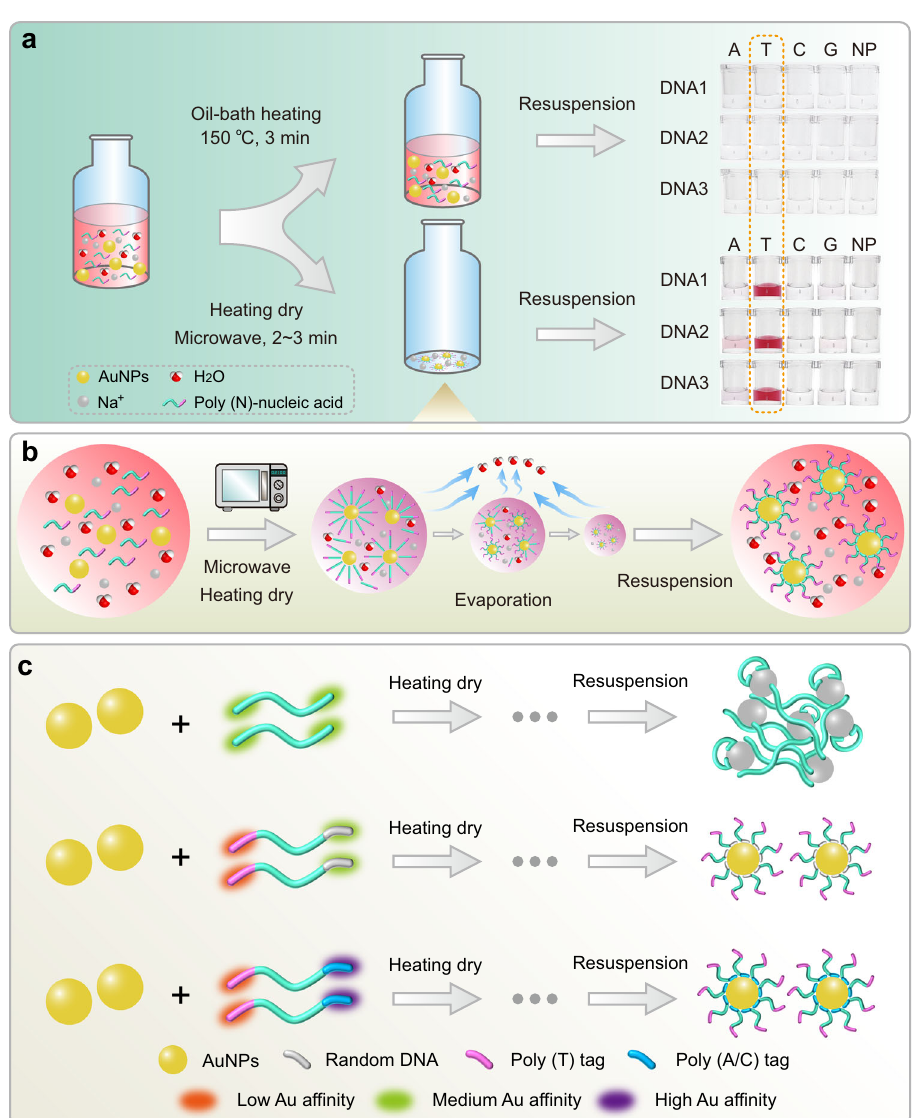
Fig. 5 Mechanism description on DNA-AuNP conjugation by the MW-assisted heating-dry method. a Photographs showing a failed labeling with solely heating at 150 °C for 3 min, while there was a successful labeling of poly (T)-tagged DNA with heating-dry method. Poly (A/C/G)-tagged DNA and non- poly base (NP) DNA probes exhibited failed labeling. An inef fi cient and failed labeling will lead to the AuNPs aggregation. b MW-assisted heating-dry method involves two consecutive processes: (i) MW-assisted heating induced high temperature unwinds the coiled structure of oligonucleotides. (ii) MW- assisted water evaporation concentrates the DNA/RNA, AuNPs and salt, thereby accelerating the attachment of DNA/RNA on the AuNPs surface. c DNA sequences without poly (T) tag present medium Au af fi nity at both terminals. Under heating-dry conditions, DNA adsorbed on the AuNPs surface disorderly. Inadequate DNA adsorption or DNA-mediated crosslink adsorption will cause the AuNPs aggregation. Bene fi ting from the low Au af fi nity of poly (T) tag, poly (T)-tagged DNA exhibits an “ amphiphilic ” -like characteristic. Therefore, the sequence at one end (either a random sequence with medium Au af fi nity or poly (A/C) sequence with high Au af fi nity) mediates the DNA-AuNP conjugation, and the poly (T)-contained sequence at the other end is distributed in the outer layer of SNA